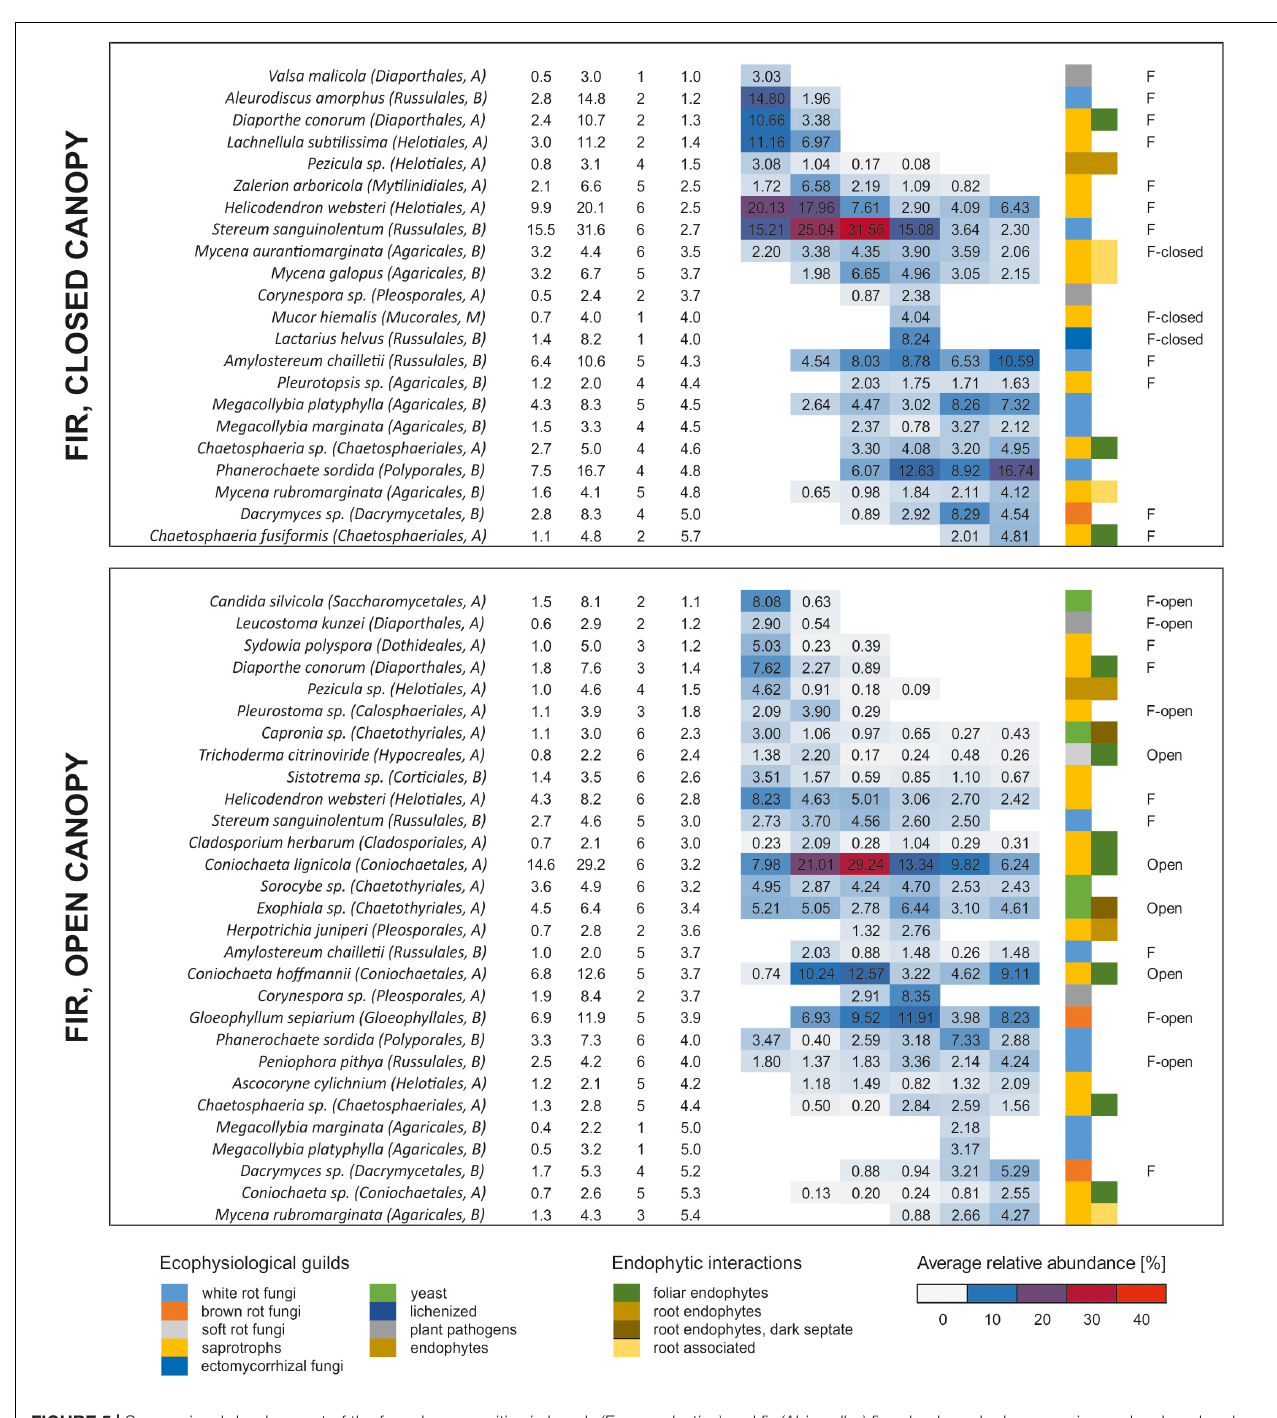
FIGURE 5 | Successional development of the fungal communities in beech (Fagus sylvatica) and fir (Abies alba) fine deadwoods decomposing under closed and open canopies in a natural temperate forest. All taxa with abundances above 1% in 3 yearly observations or maximum relative abundances in any single year over 2% were